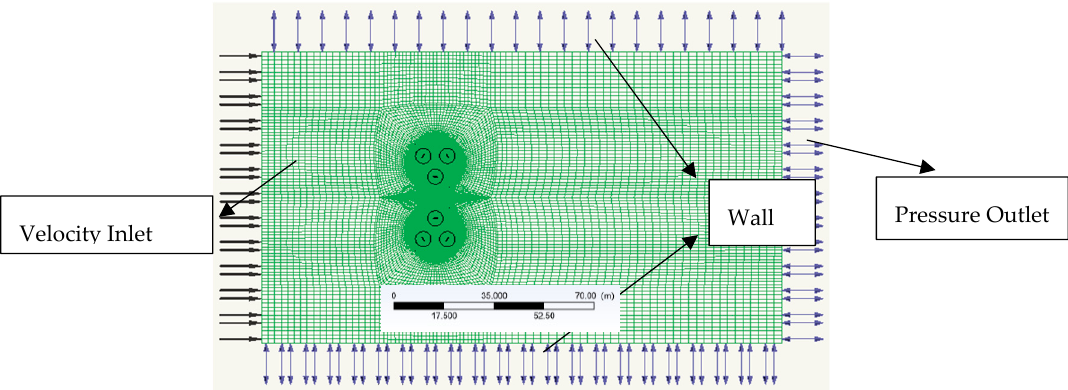
Figure 5. Boundary settings of the computing domain.